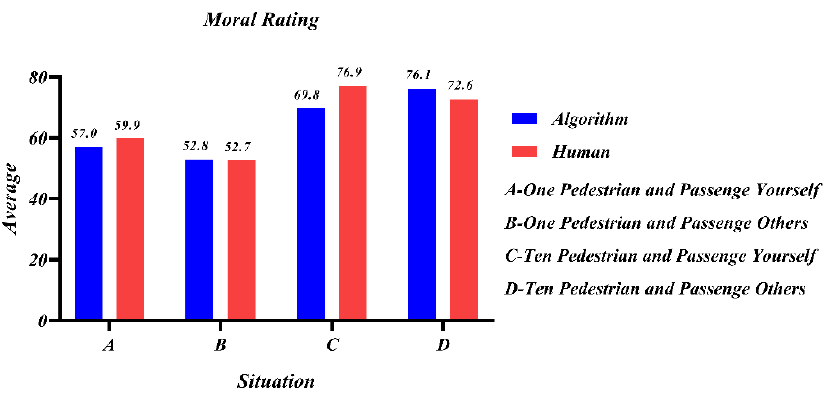
Figure 8. Mean of the moral evaluation scores for participants’ choice of swerving in different situations.